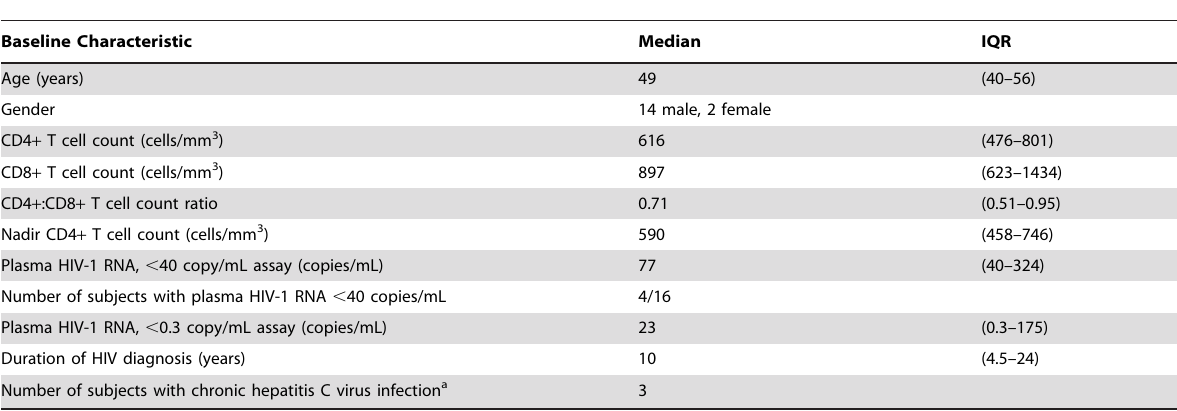
Table 1. Baseline characteristics (n